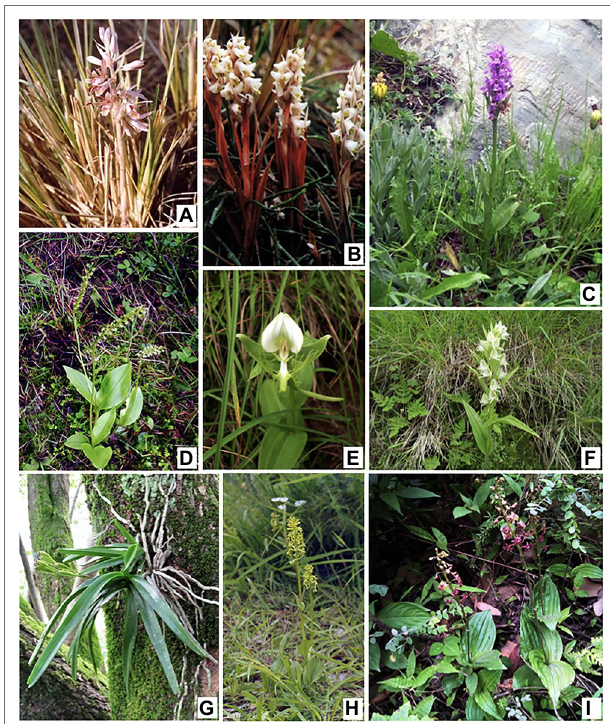
FIGURE 1 | Some therapeutically important orchid species. (A) , Eulophia dabia (D.Don) Hochr.; (B) , Zeuxine strateumatica (L.) Schltr.; (C) , Dactylorhiza hatagirea (D.Don) Soó; (D) , Malaxis muscifera (Lindl.) Kuntze; (E) , Habenaria intermedia D.Don; (F) , Habenaria pectinata D.Don; (G) , Vanda testacea (Lindl.) Rchb.f.; (H) , Platanthera edgeworthii (Hook.f. ex Collett) R.K.Gupta; (I) , Crepidium acuminatum (D.Don)